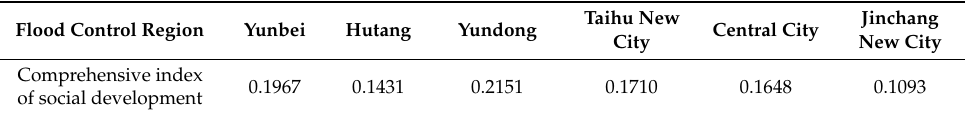
Table 3. Comprehensive index of regional social